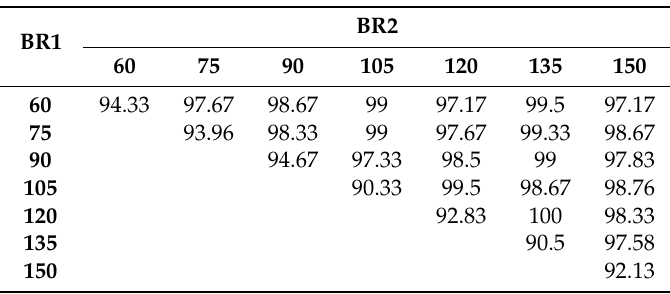
Table 1. SFPD detection accuracy—FAAC (%).